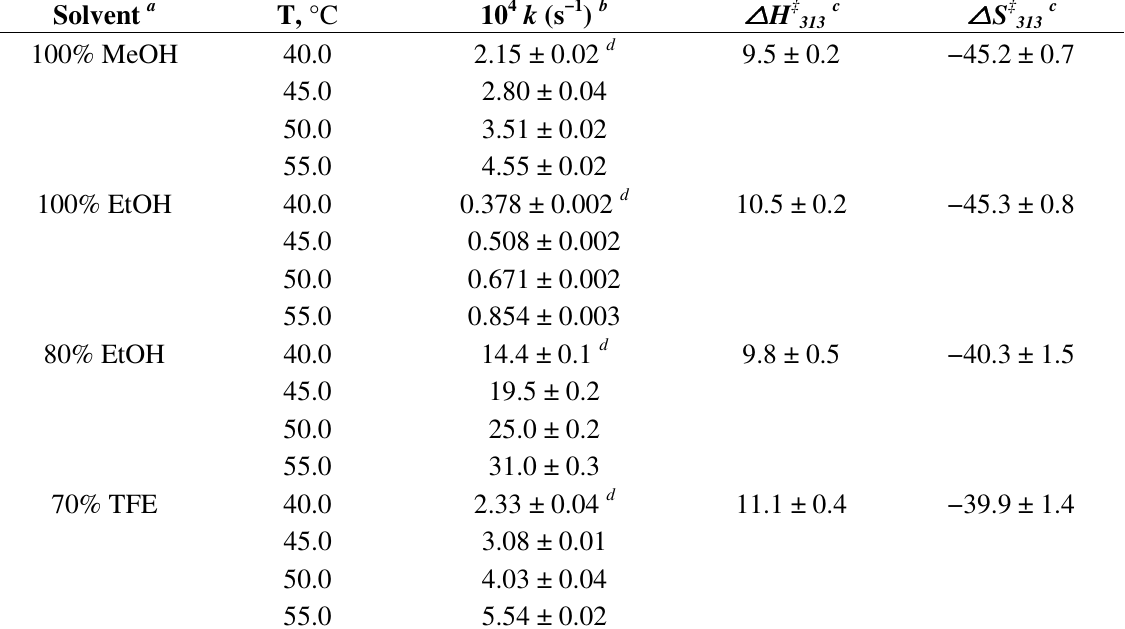
Table 2. Specific rates for solvolysis of isobutyl fluoroformate ( 1) at various temperatures and enthalpies ( △ H ‡ kcal·mol −1 ) and entropies ( △ S ‡ , cal·mol −1 ·K −1 ) of activation. ,